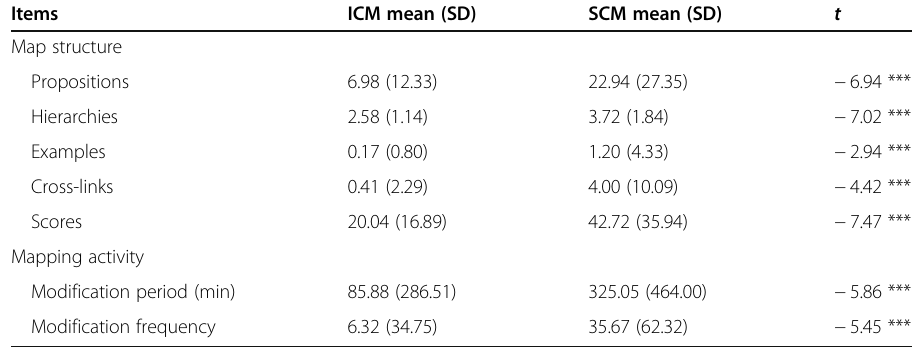
Table 3 Descriptive statistics and independent t test results for concept map structure and activity